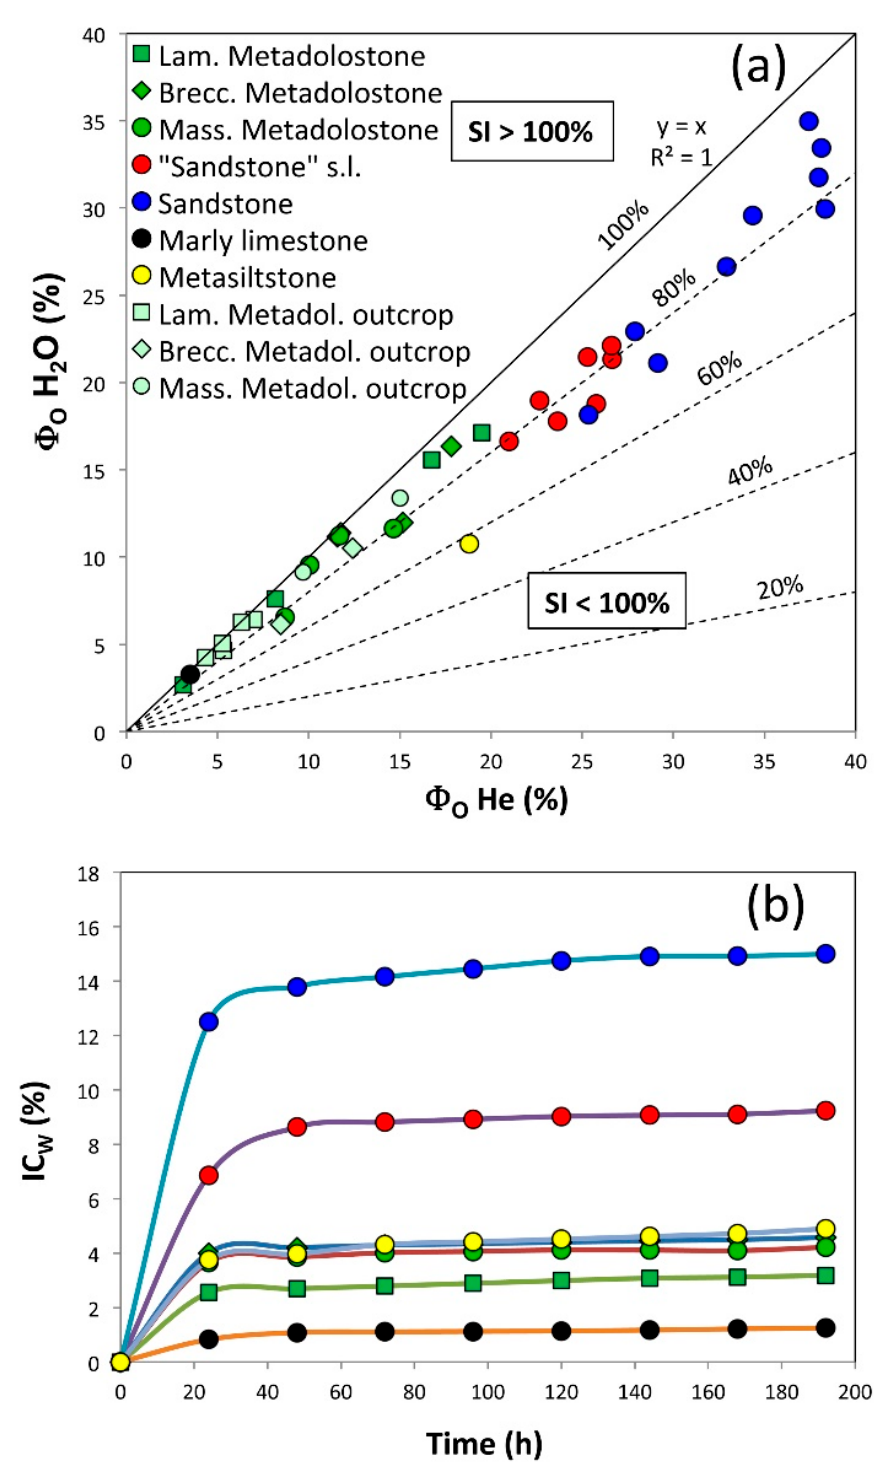
Figure 12. ( a ) Helium open porosity ( Φ O He) vs. water open porosity ( Φ O H 2 O); ( b ) kinetic of water absorption shown by imbibition coefficient (IC W ) over 192 h.